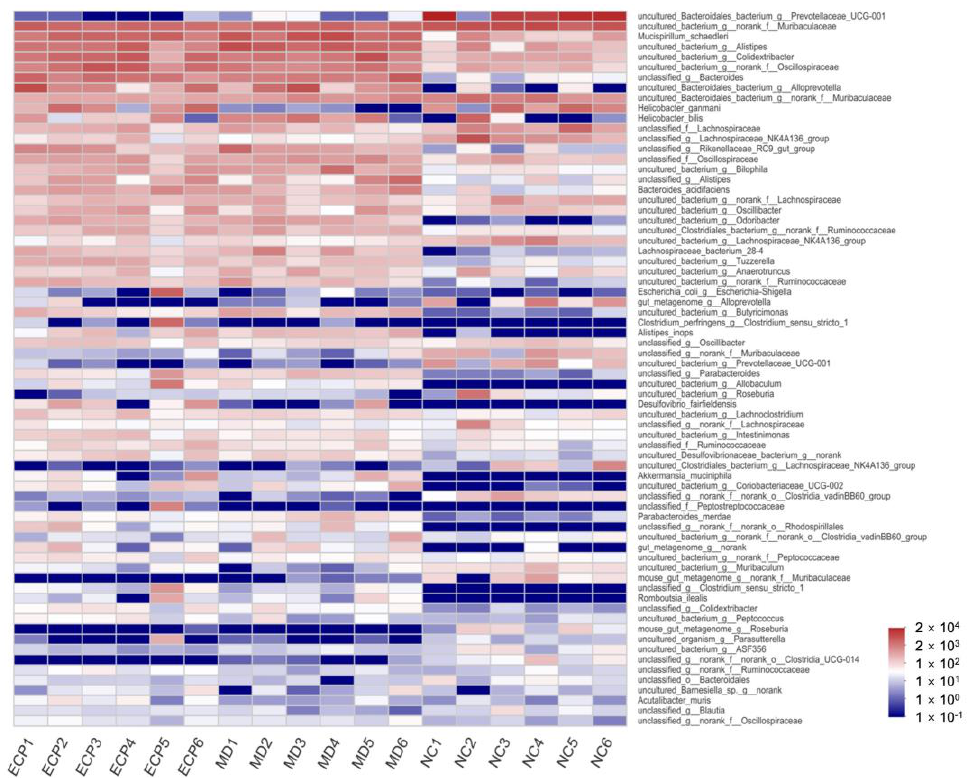
Figure 4. Heatmap analysis of the composition of the gut microbiota at the genus level. The data are expressed as lg value.